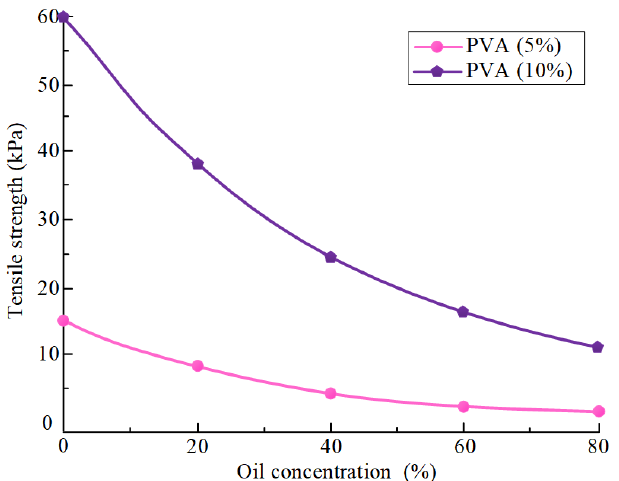
Figure 4. The dependence of the tensile strength of oil-filled cryogels fuel pellets on the oil concen- tration at different concentrations of PVA aqueous solutions [109]. tion at different concentrations of PVA aqueous solutions [109].